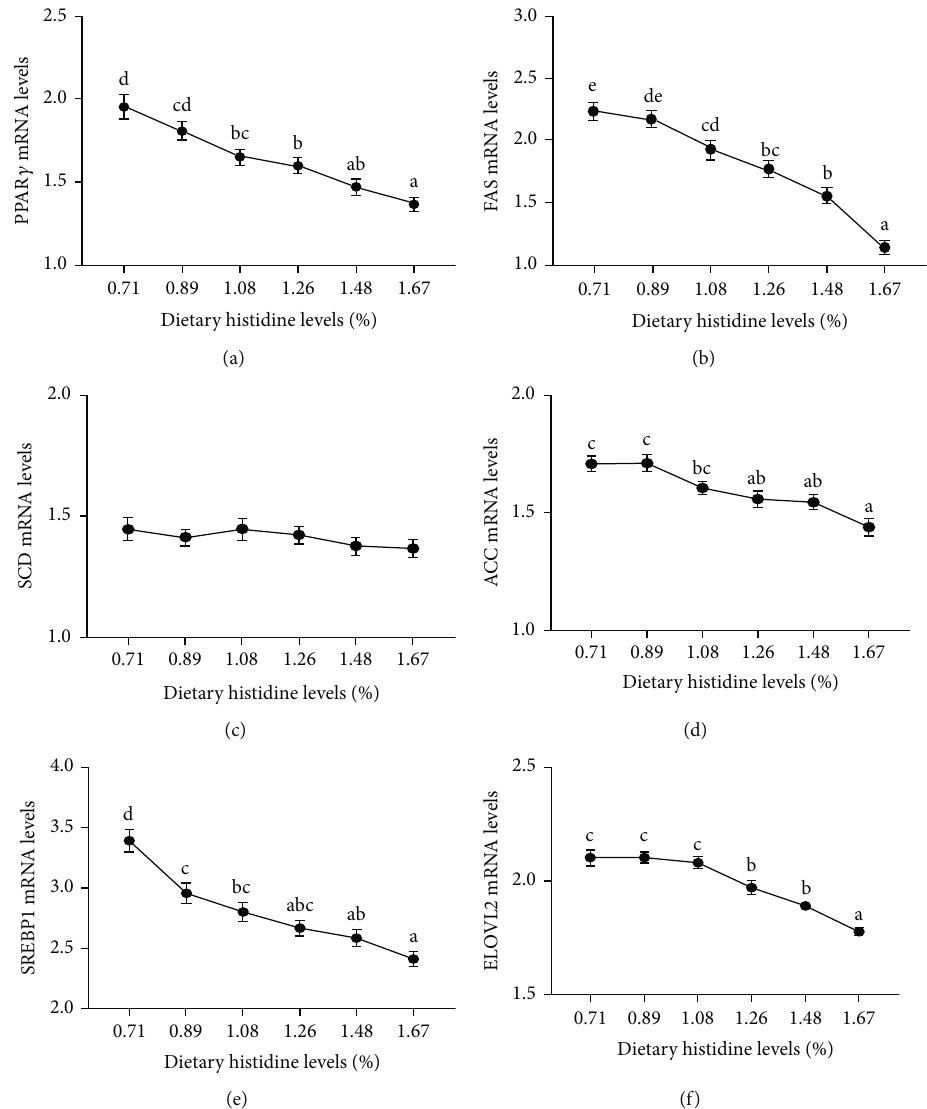
Figure 8: The relative expressions of PPAR γ signaling pathway in liver of juvenile largemouth bass fed with di ff erent levels of dietary histidine. Data are expressed as means with S.E.M.; value with di ff erent superscripts are signi fi cantly di ff erent ( P < 0 : 05